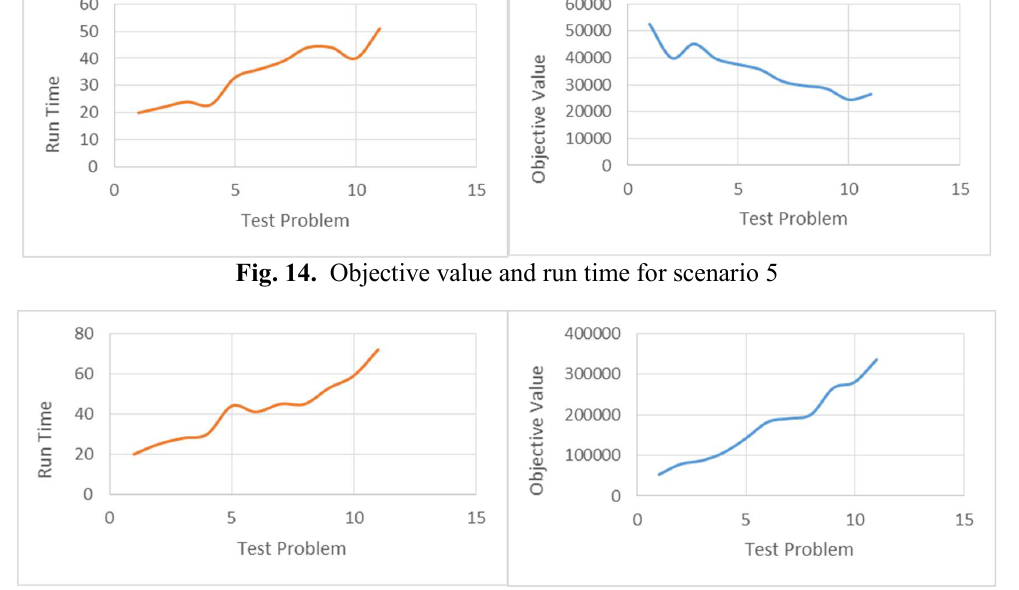
Fig. 15. Objective value and run time for scenario